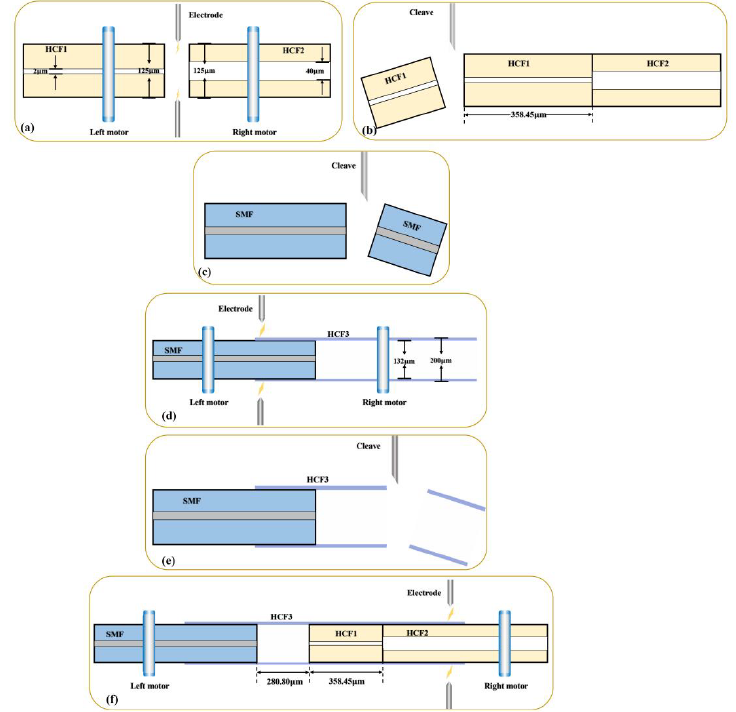
Figure 1. ( a – f ) Steps of the FPI sensor fabrication process.